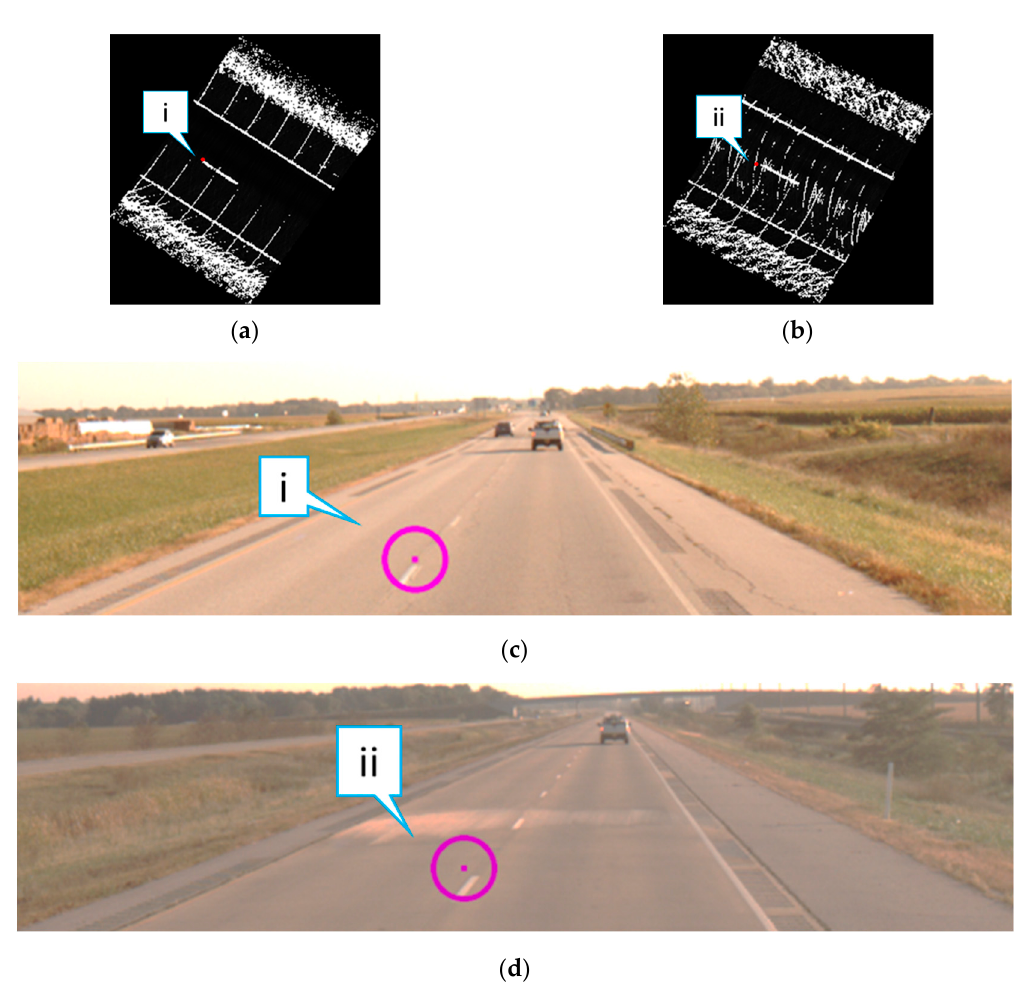
Figure 24. Illustrations of intensity images in ( a ) asphalt pavement area and ( b ) concrete pavement area, and corresponding RGB imagery for ( c ) location i and ( d ) location ii in dataset 3.